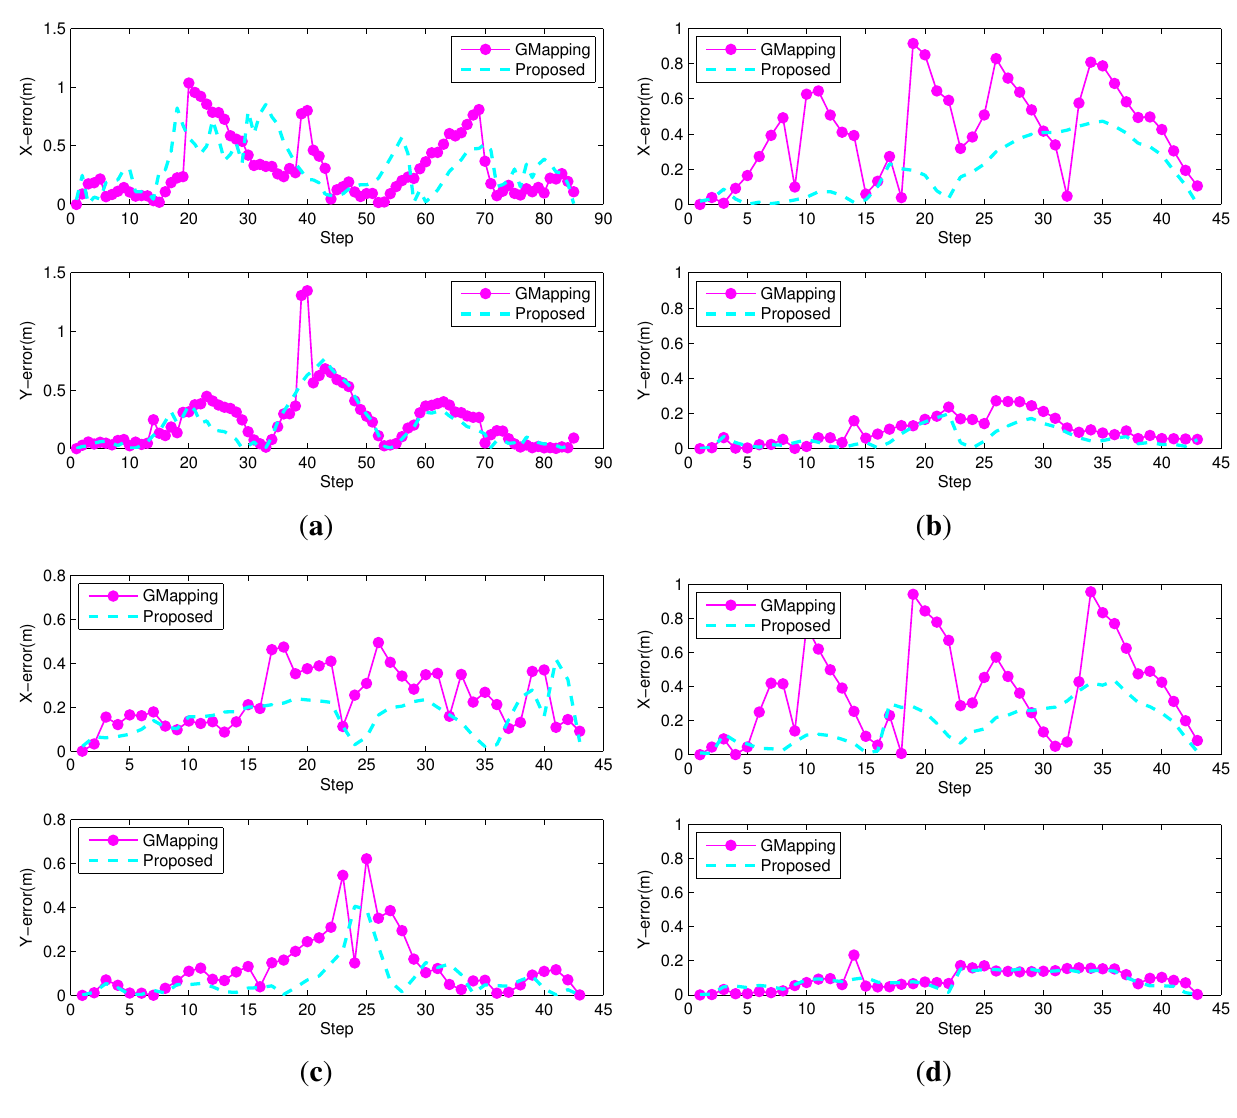
Figure 14. Position error at each time step for GMapping and the proposed method. ( a ) Dataset 1; ( b ) Dataset 2; ( c ) Dataset 3; ( d ) Dataset